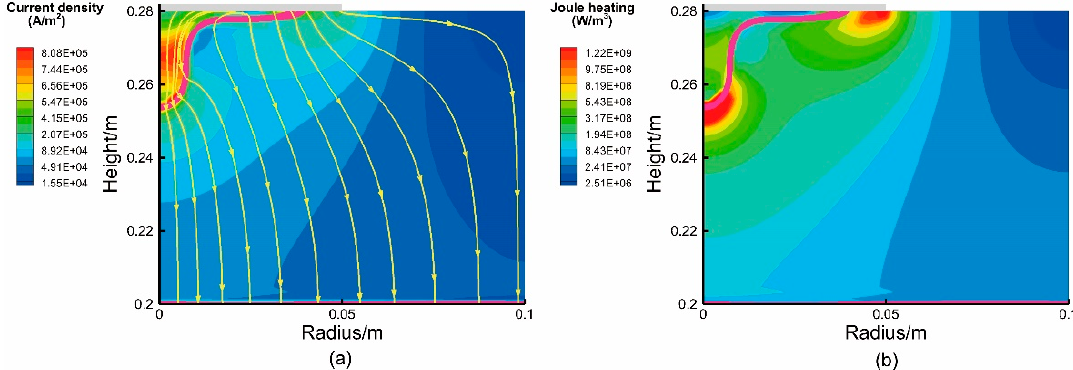
Figure 10. Predicted distributions of current density ( a ) and Joule heating ( b ) at 2425.15 s. The red lines represent the slag/metal interface. The yellow lines represent the current streamlines.